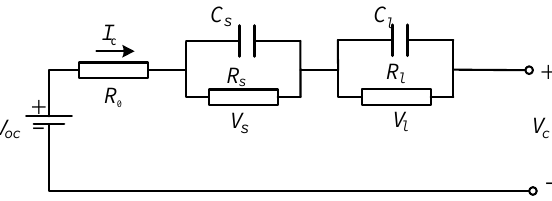
Figure 1. Second-order R-C equivalent circuit model (ECM).